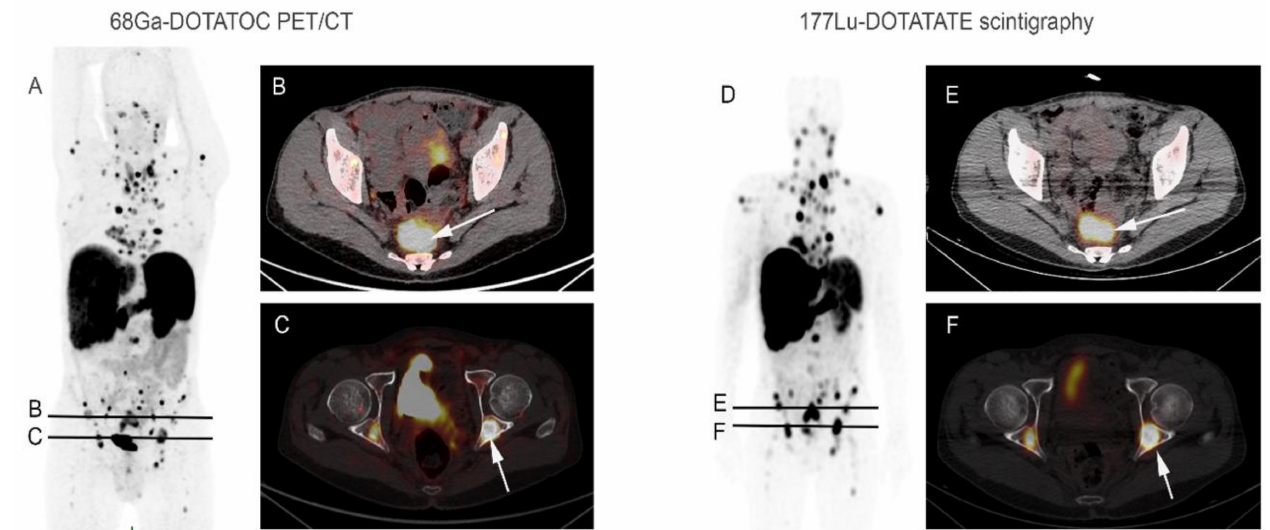
Figure 1. A 65-year-old man with metastatic well-differentiated grade 2 rectal neuroendocrine tumor, progressive after chemotherapy, addressed for PRRT. 68 Ga-DOTATOC PET/CT maximum intensity projection image ( A ) and axial fused PET/CT images ( B , C ) showed high multiple focal uptakes, corresponding to mediastinal, abdominal lymph nodes, liver and bone lesions (( C ) arrow: example of bilateral cotyle posterior wall lesions) associated with a large rectal lesion (( B ) arrow). Post 177 Lu-DOTATATE therapy whole-body image ( D ) after the first administration showed focal tracer uptake in all lesions correlating with 68 Ga-DOTATOC PET/CT images, as observed in fused SPECT/CT images ( E , F ).